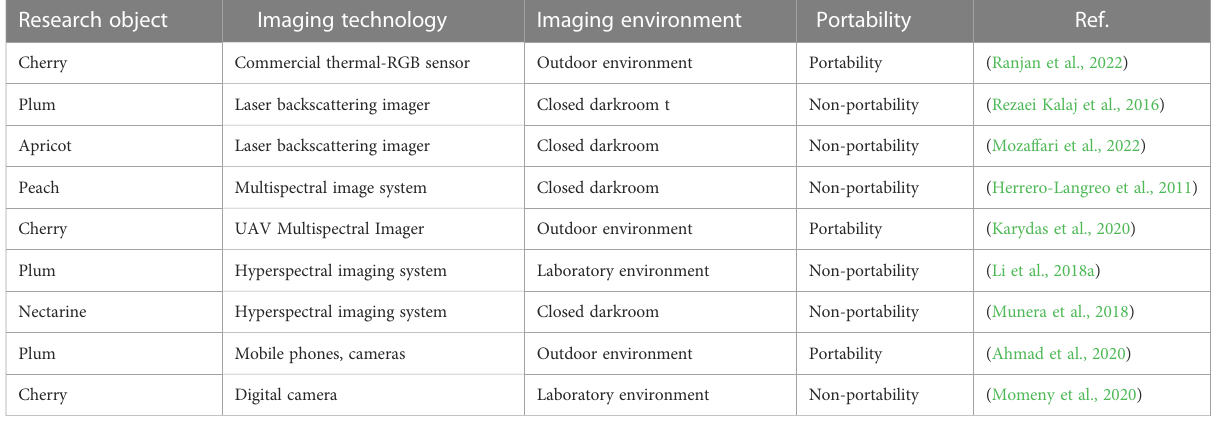
TABLE 1 Summary table of imaging technology in the acquisition of fruit phenotypic information and related research. Research